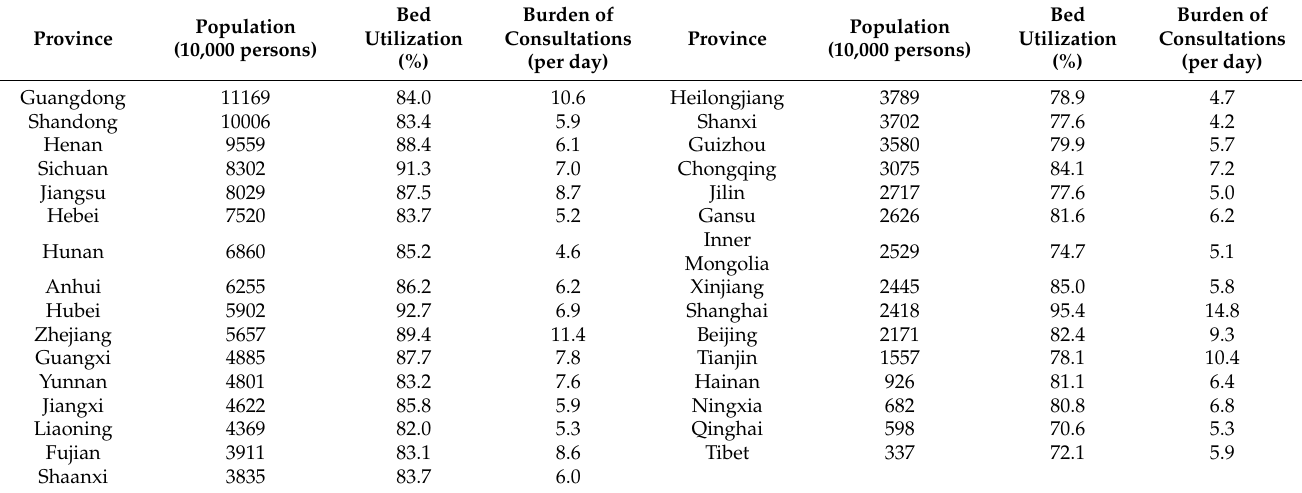
Table 5. China’s population and health services by province